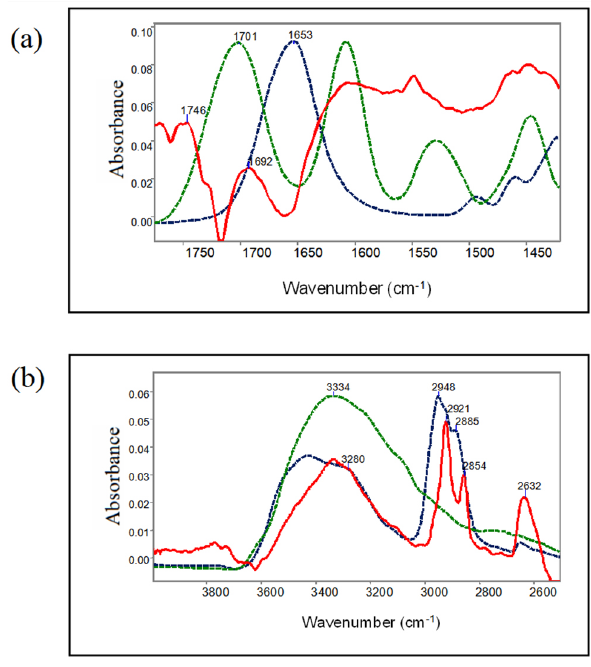
Figure 3: ATR-FTIR spectra of PVP (blue), TAN (green) and multilayer PVP/TAN film (red) for the carbonyl stretching (a) and the hydroxyl stretching regimes (b).